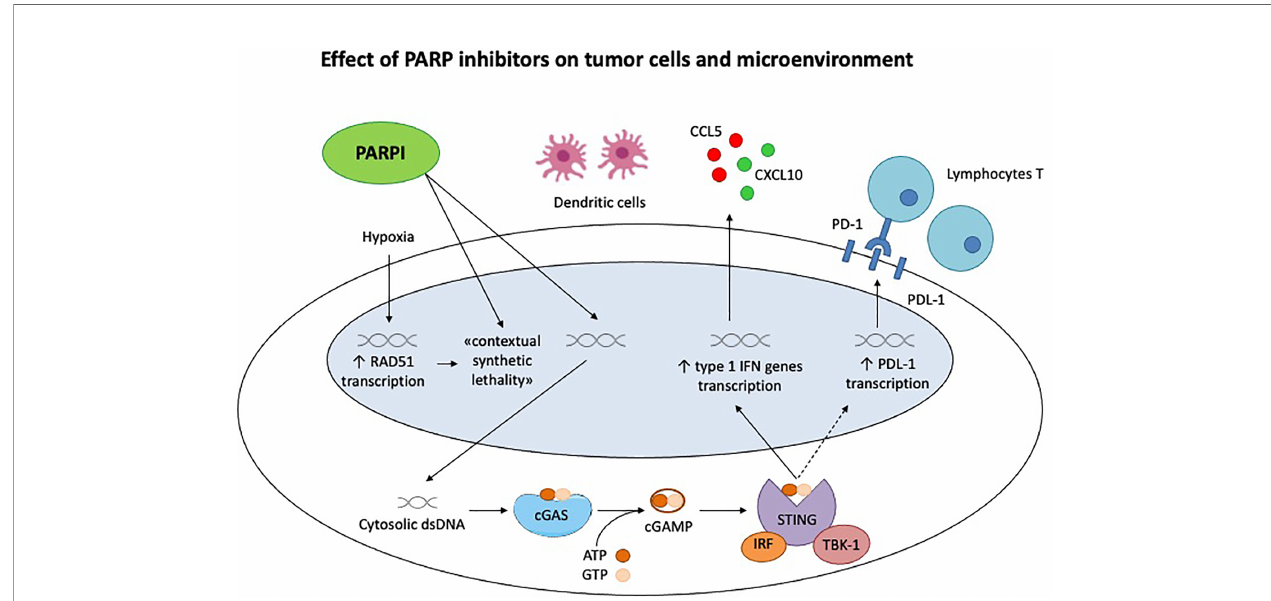
FIGURE 1 | Effect of PARP inhibitors on tumor cells and microenvironment. Chronic hypoxia decreases transcription of homologous recombination proteins, as RAD51, rendering the tumor cells susceptible to PARP inhibitors. This is the concept of «contextual synthetic lethality». Cytosolic double-strand DNA (dsDNA) fragments, generated by the effect of Parpi on tumor cells, activate cGAS-cGAMP-STING pathway, leading to the transcription of type 1 IFN genes and the production of pro in fl ammatory cytokines. This generates a signi fi cant immune response, recruiting activated lymphocytes T and dendritic cells. STING pathway activates also the PDL-1 transcription, inhibiting the immune system through PD-1/PDL-1